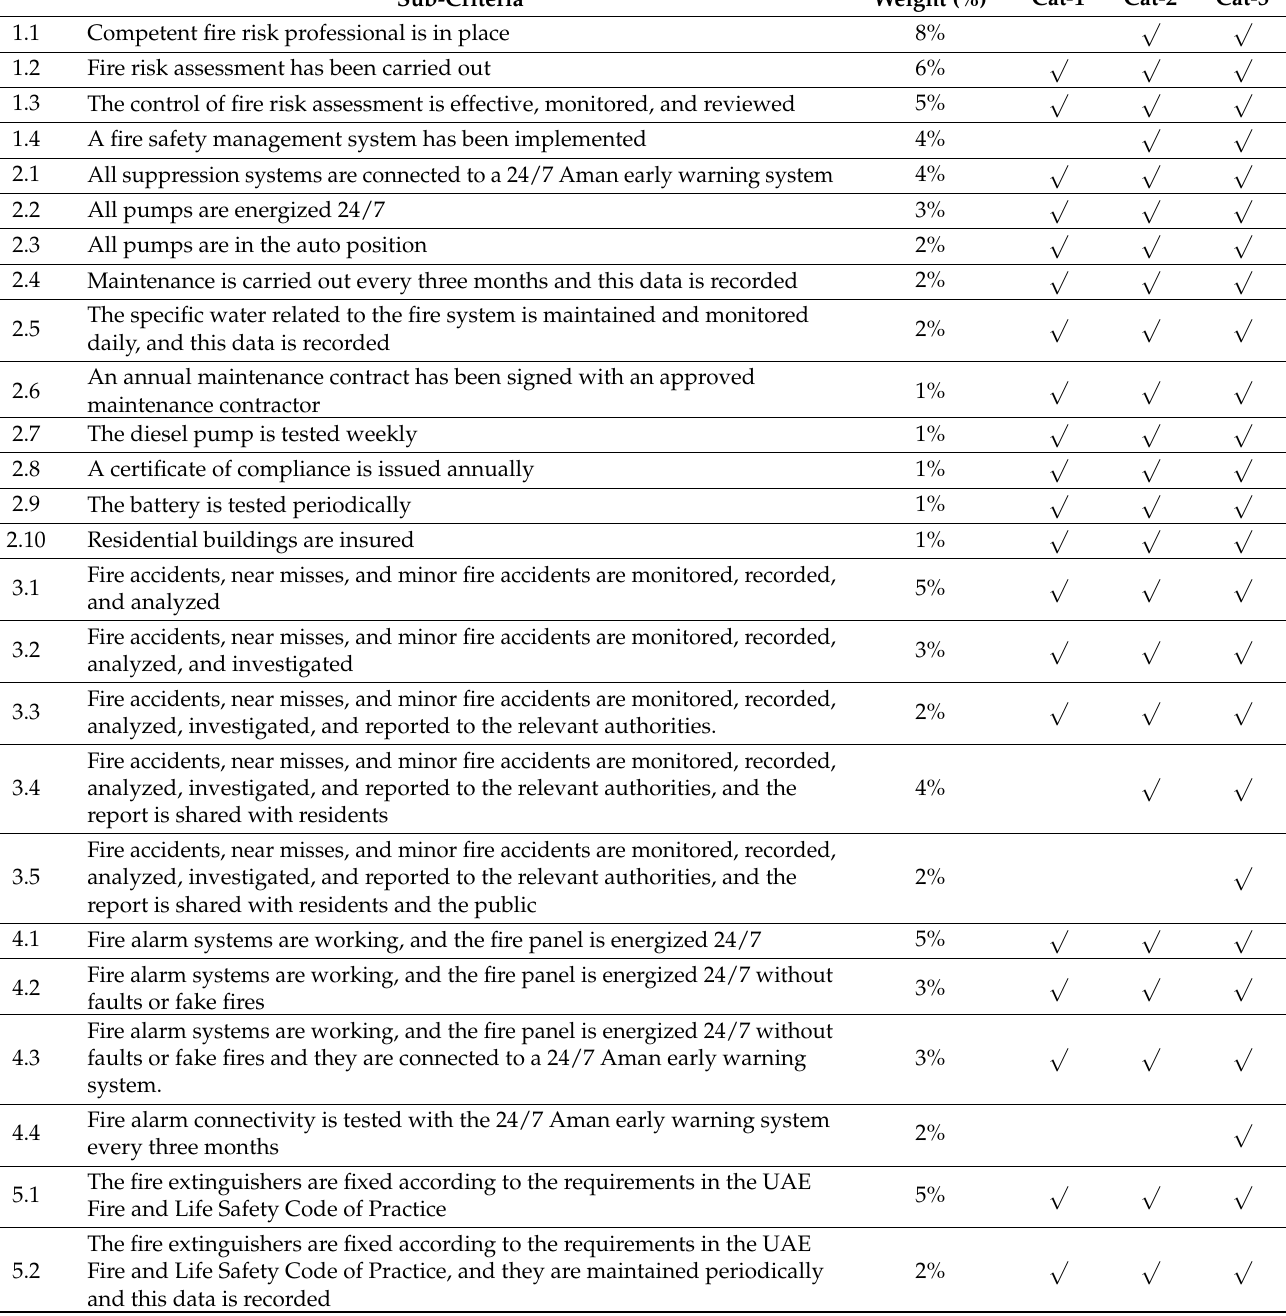
Table 4. Minimum requirements